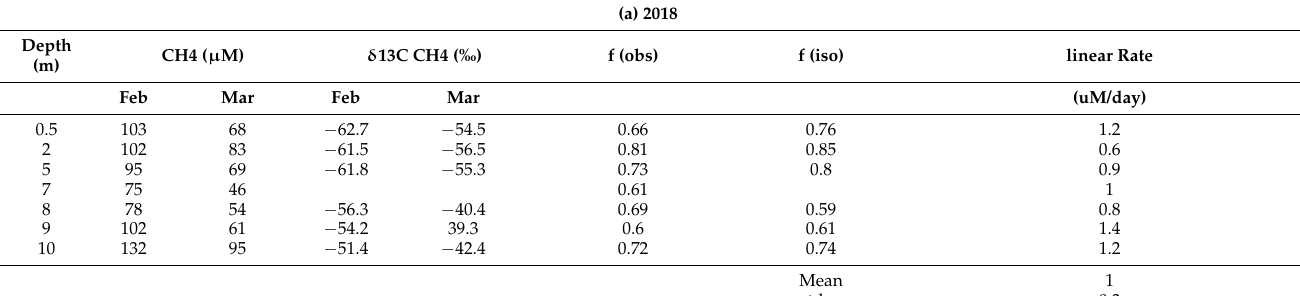
Table 1. Methane loss modeling. Comparison of calculated and observed extents and rates of methane. Observed extent of reaction presented as fraction of reactant remaining (fobs) determined by comparison of measured methane concentrations at comparable depths. Calculated extent of reactions based on extent of isotopic fractionation of δ 13 C CH 4 for comparable depth, and calculated using the Rayleigh fractionation model, ε lnf = ln((( δ 13Cr/1000) + 1)/(( δ 13Cro/1000) +1)), as per Slater 2003 [51], assuming an isotopic enrichment factor of − 30‰ [15]. Table 1 reports assessment of under-ice methane oxidation between February and March 2018. In 2018, f obs and f iso were within 15%, and often within 5%. Linear rate of methane loss calculated from f iso data for consistency to 2017 (Table 1b). Table 1 reports results for intervals between under-ice conditions and ice off (Feb–May), and during spring (May to June) in